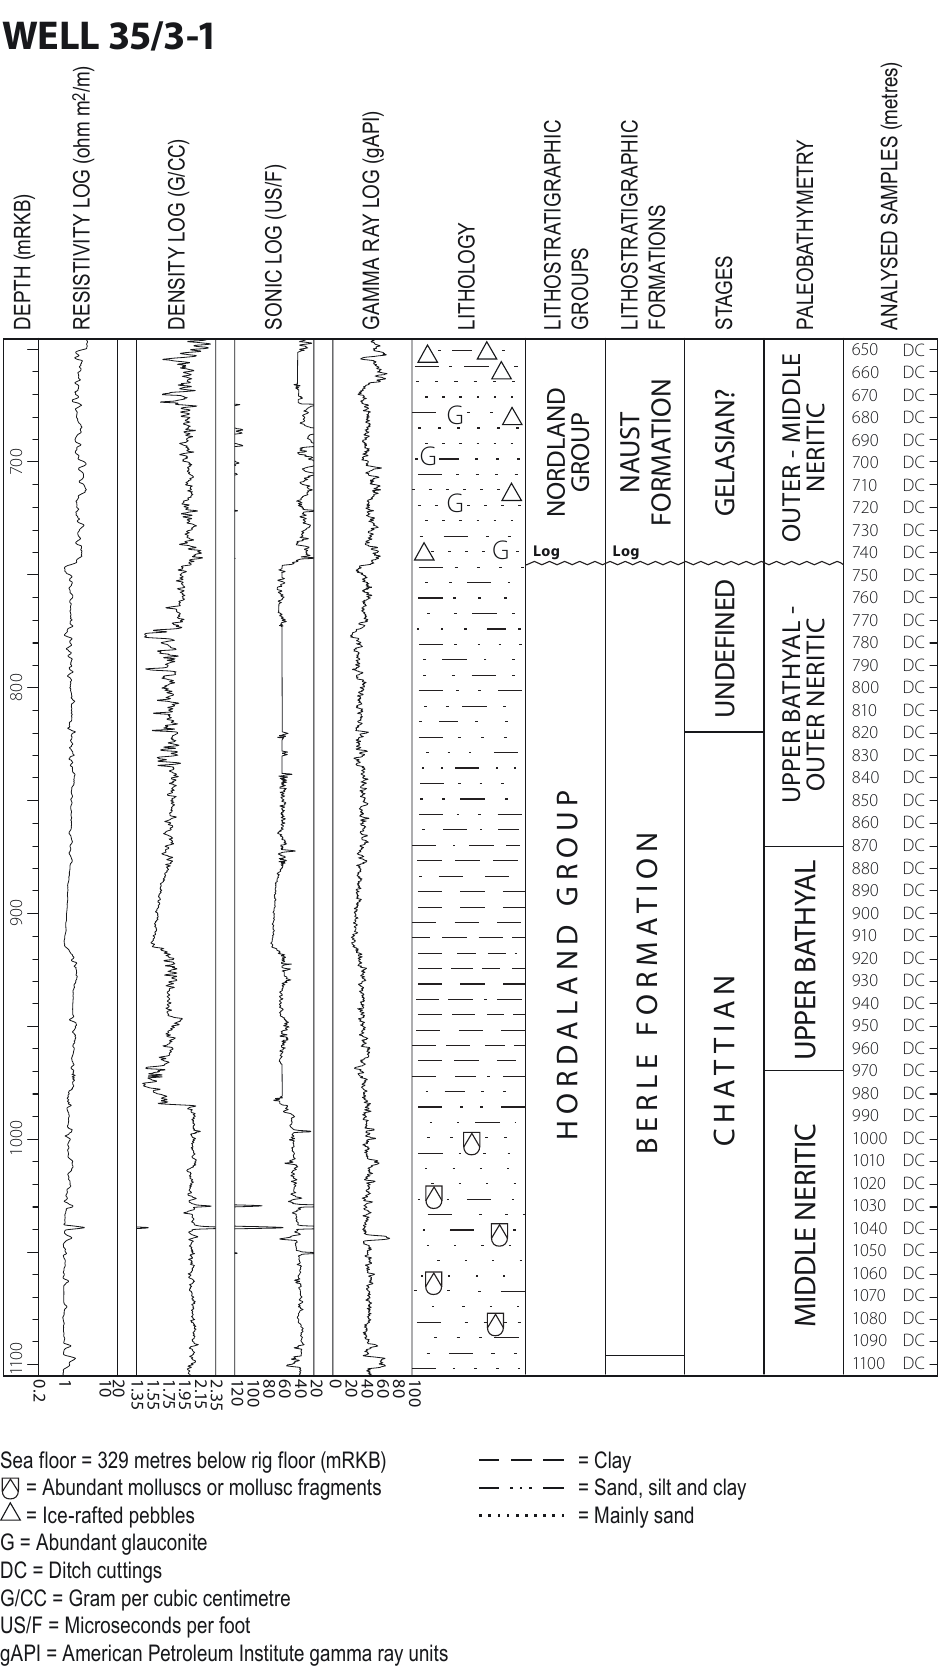
Figure 37. Well summary figure including resistivity log, density log, sonic log, gamma-ray log, lithology, litho- stratigraphic units, stages, paleobathymetry and analysed samples for the investigated sequence in well 35/3–1 (Chattian to Gelasian?) including the well reference section for the Berle Formation (modified after Eidvin et al.,